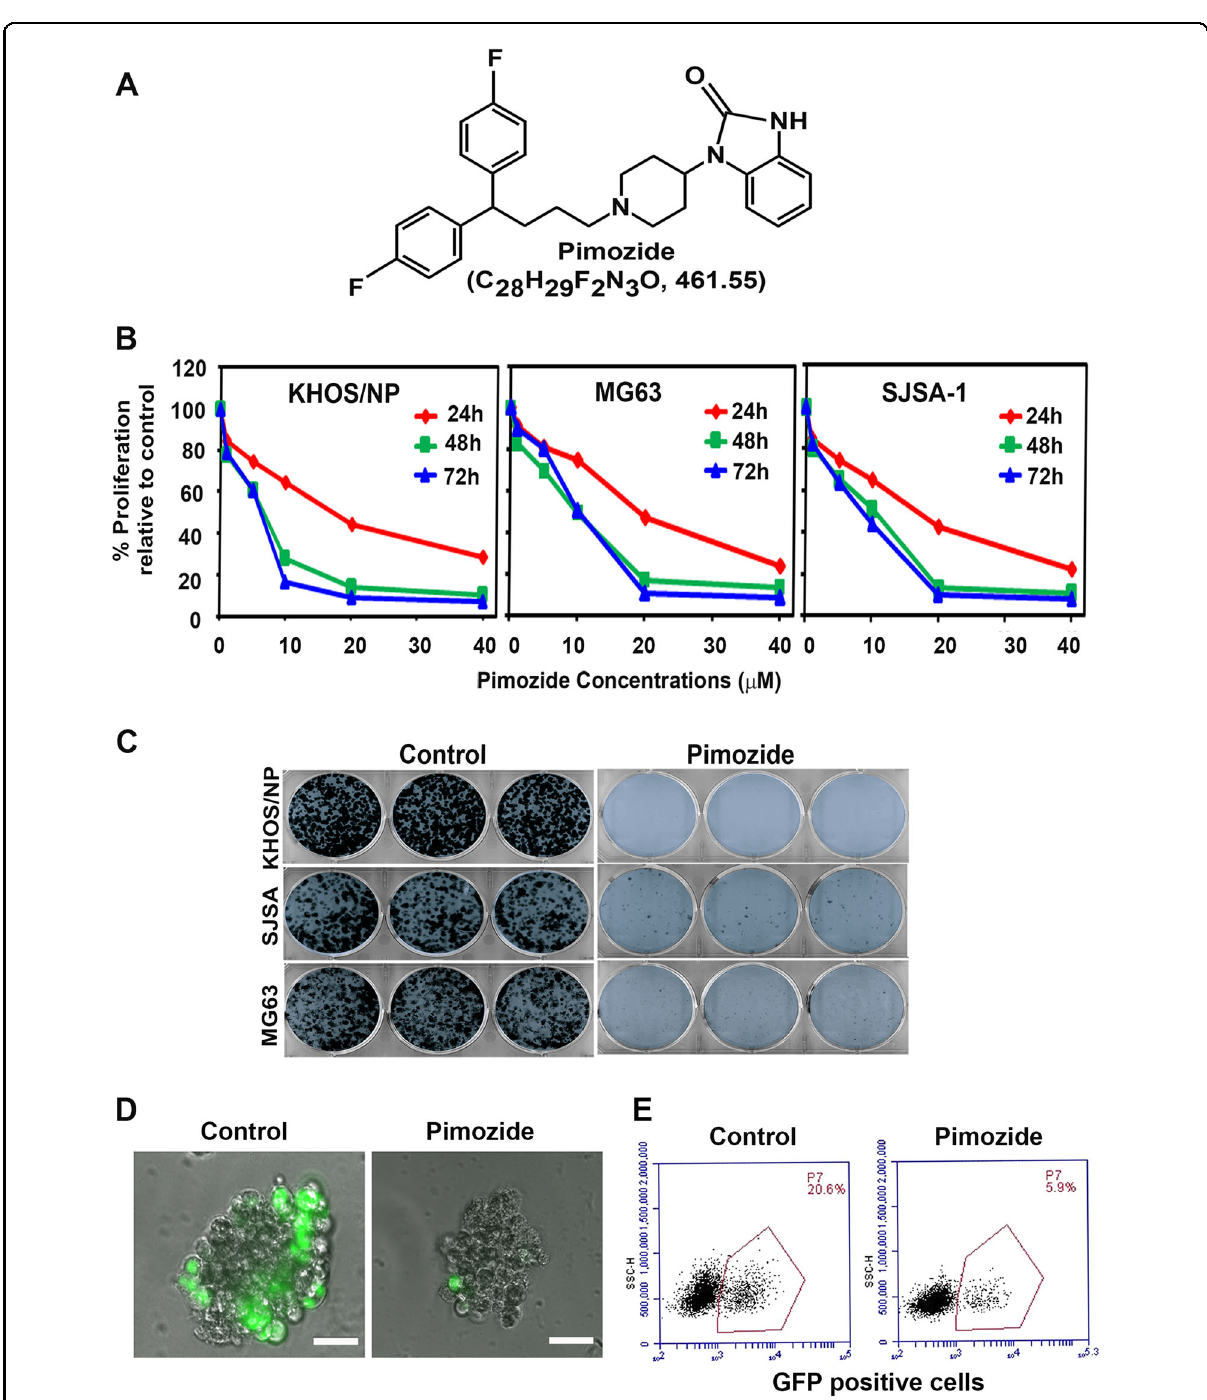
Fig. 1 Pimozide inhibits osteosarcoma growth. a Pimozide structure. b KHOS/NP, MG63, and SJSA-1 cells were incubated with increasing doses of pimozide (0 – 40 μ M), and cell proliferation was determined. Pimozide treatment resulted in a signi fi cant dose-and time-dependent decrease in cell proliferation in all cell lines when compared with controls. c KHOS/NP, MG63, and SJSA-1 cells were incubated with 10 µM pimozide for 48 h and the cells were allowed to grow and form colonies. Pimozide treatment inhibits colony formation. Results are representative of three independent experiments. d and e Pimozide at 20 μ M concentration speci fi cally inhibits the growth of KHOS/NP GFP positive cells, but not the normal cells in the TiD system. Scale bars represent 100 μ